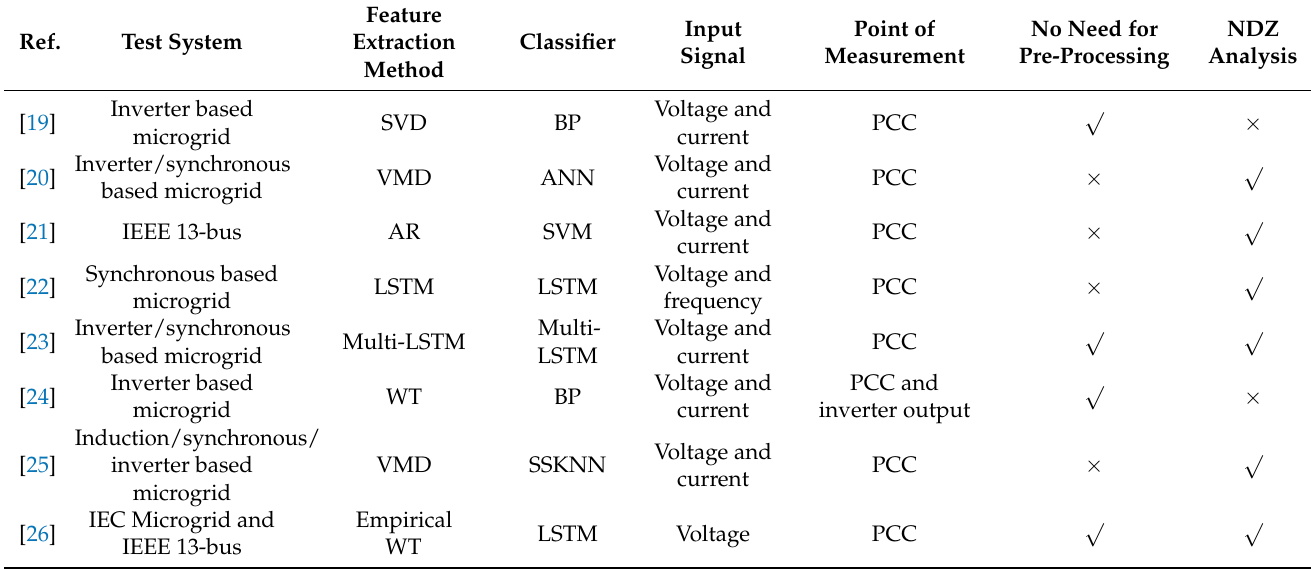
Table 1. Comparison of the proposed method with related methods described in the literature.